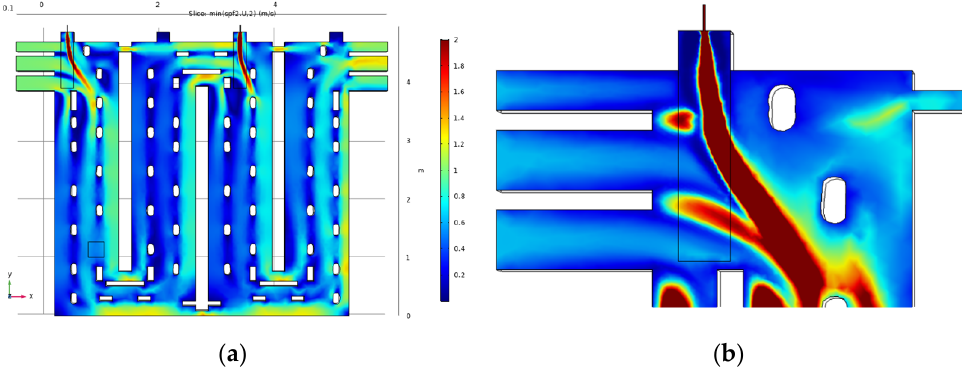
Figure A2. Results of the model of Figure A1 using mesh 4 (Inlet velocity of fuel: 70 m/s. Viscosity 1.8 × 10 − 5 Pa·s): ( a ) Velocity results (m/s) ( b ) turbulent viscosity ratio.